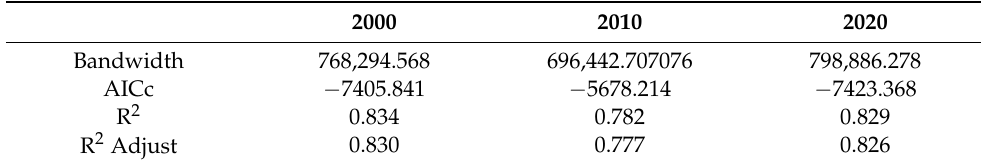
Table 5. Test result of the GWR model.